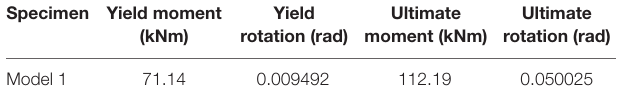
TaBle 1 | Summary of bilinear idealization of moment–rotation curve (Tsavdaridis and Papadopoulos, 2016).